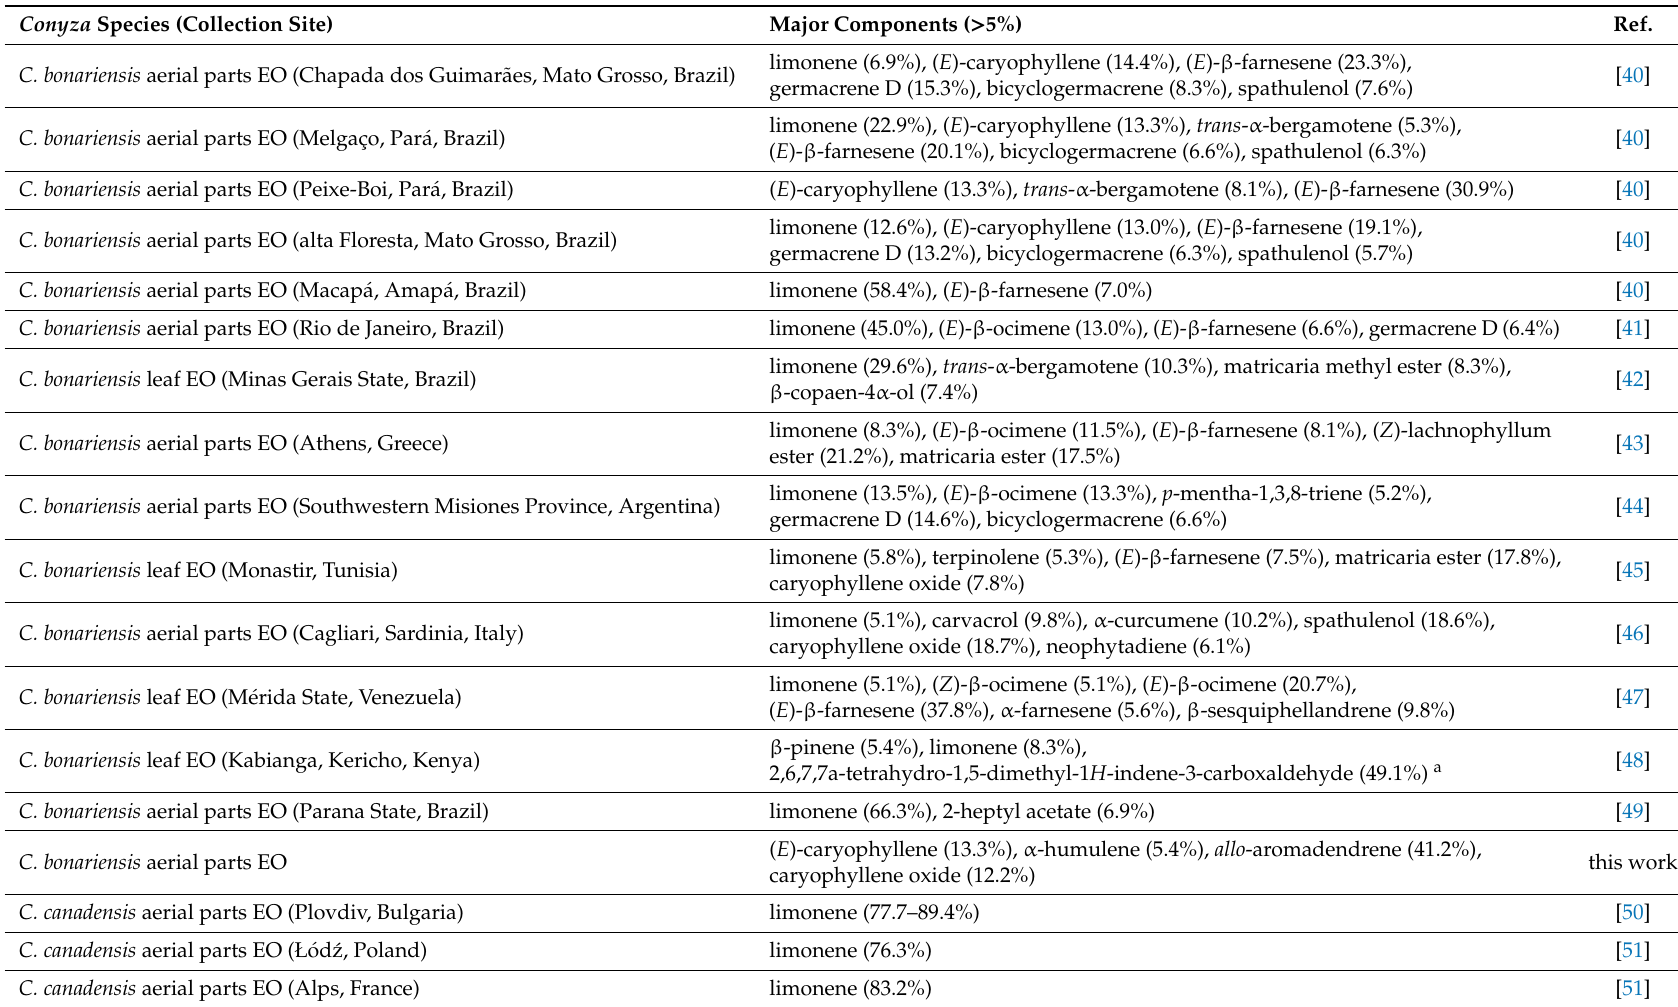
Table 2. Major components of Conyza bonariensis , Conyza canadensis , and Conyza sumatrensis essential oils from di ff erent geographical locations. Conyza Species (Collection